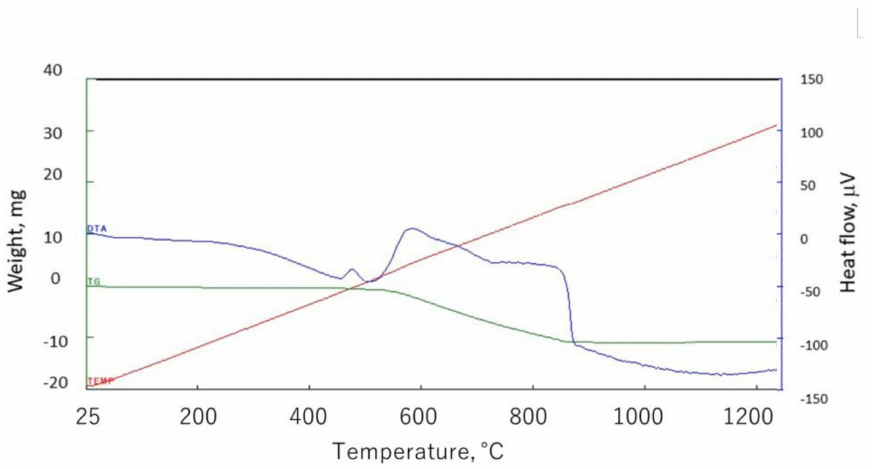
Figure 5. Measurement of shungite via thermogravimetry-differential thermal analysis under air conditions and at 10 ◦